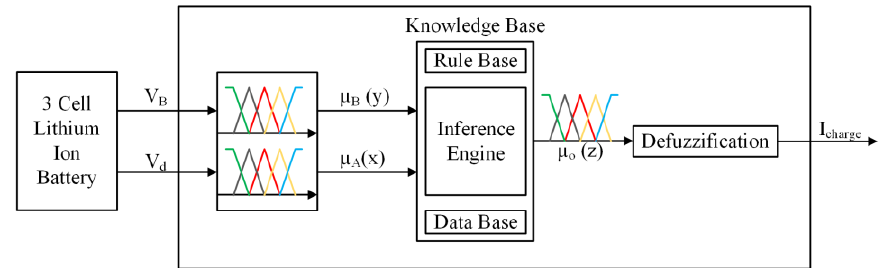
Figure 2. Fuzzy logic system; V B = lowest single-cell voltage of the string, V d = highest voltage difference between two cells of a battery, µ B = fuzzy variable of V B , µ A = fuzzy variable of V d , I charge = Output Charging Current, and µ o = fuzzy variable of I charge .